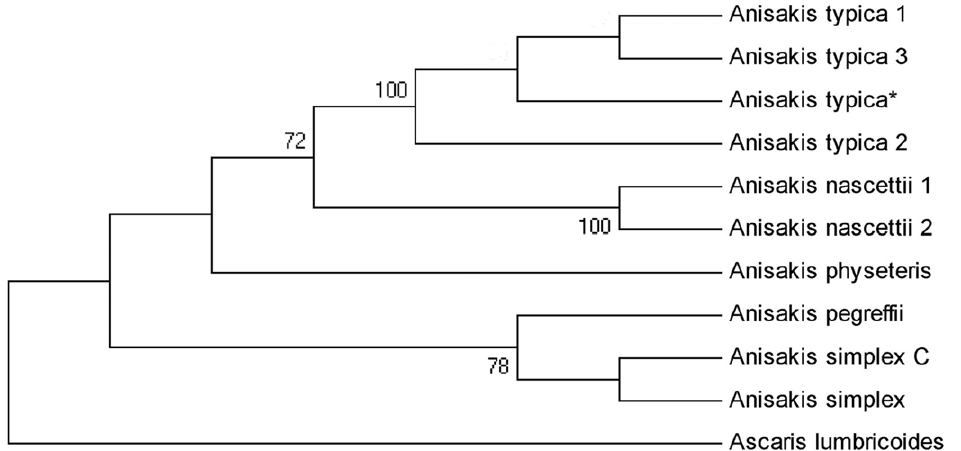
Figure 4. Maximum likelihood reconstruction between sequences of Anisakistypica obtained in this study (*) and sequences of Anisakis species from the GenBank, with the tree inferred from mtDNA cox -2 and LSU data sets. The numbers on the tree branches represent the percentage of bootstrap resampling. Ascaris lumbricoides was used as an out group.